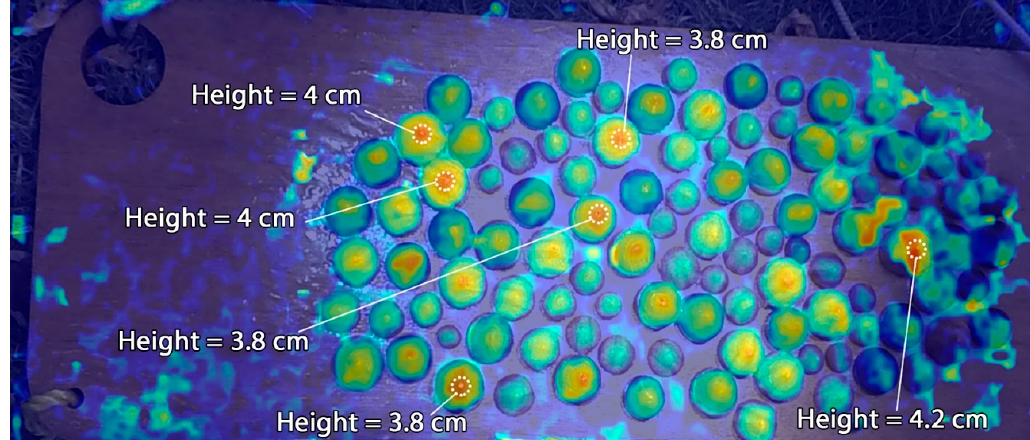
Figure 10. Overlay of the height map and the original image. The estimated heights for notable peaks are shown..